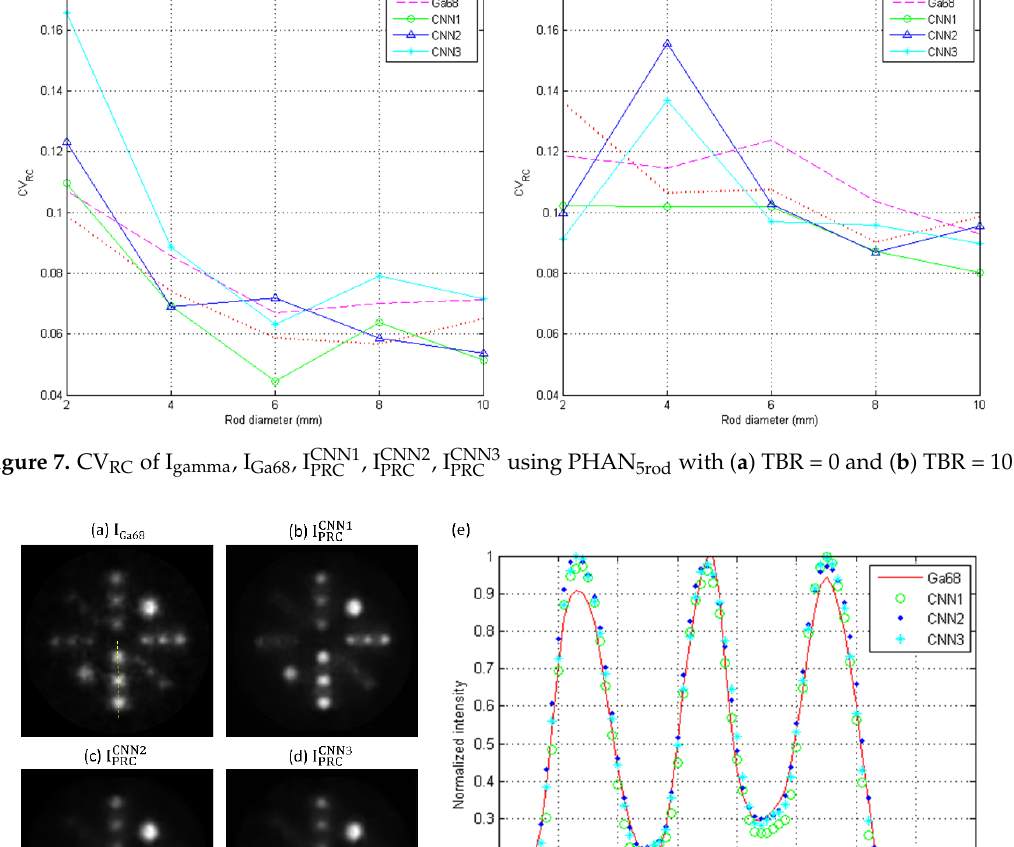
with ( a ) TBR = 0 and ( b ) TBR = 10. 5rod